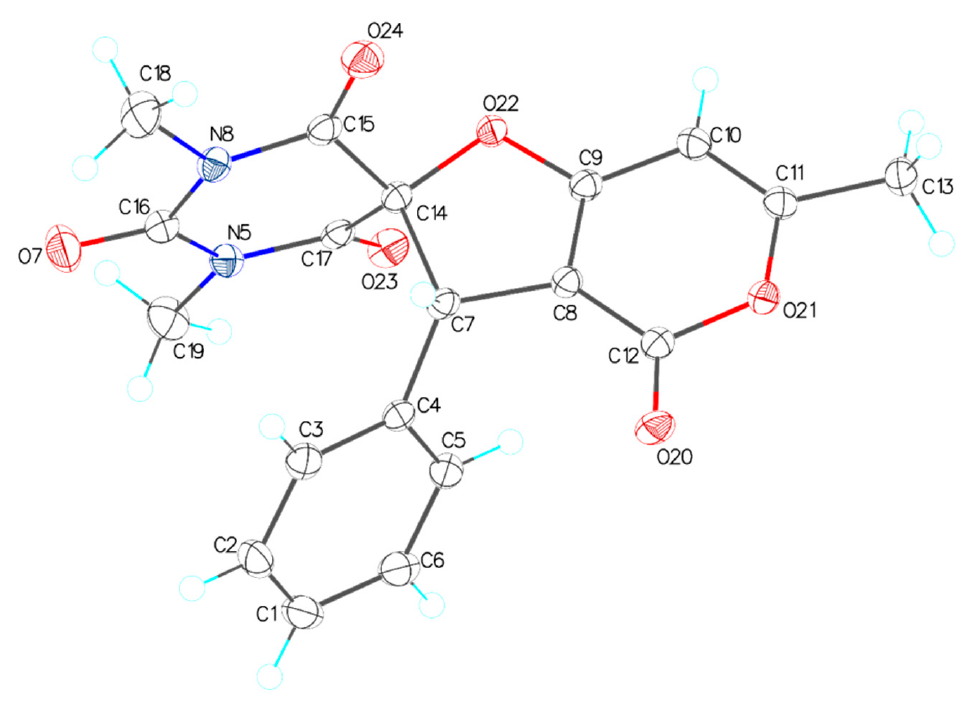
Figure 1. The general view of compound 2a in crystal. Atoms are represented by thermal displace- ment ellipsoids ( p = 50%).